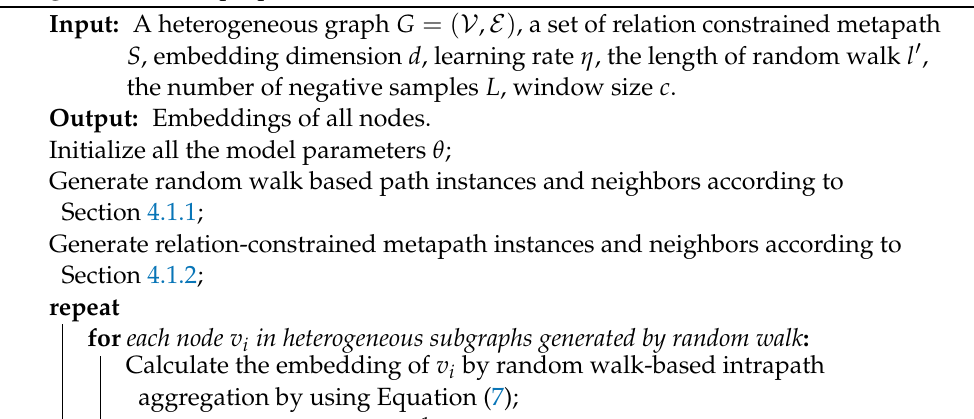
Algorithm 1: The proposed